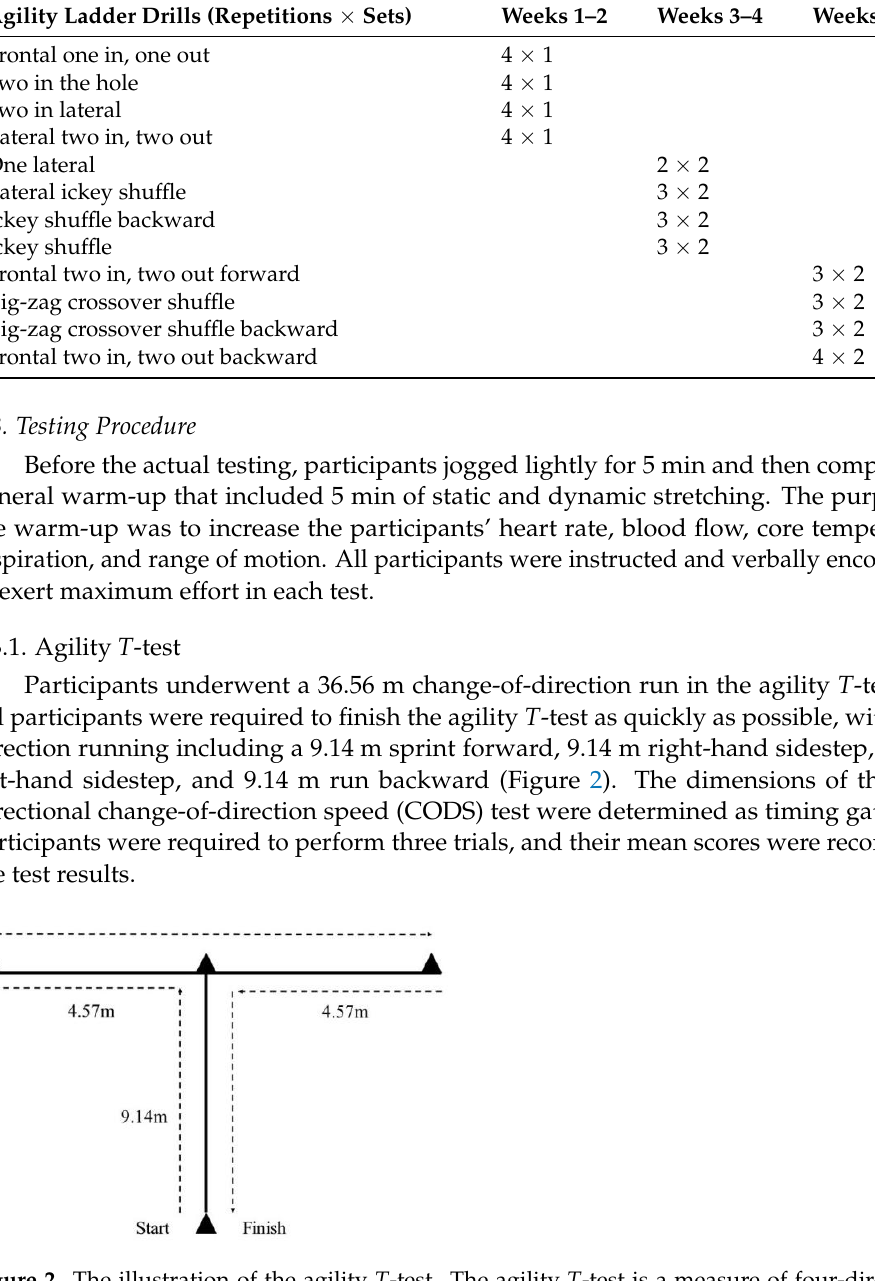
Figure 2. The illustration of the agility T -test. The agility T -test is a measure of four-directional change-of-direction